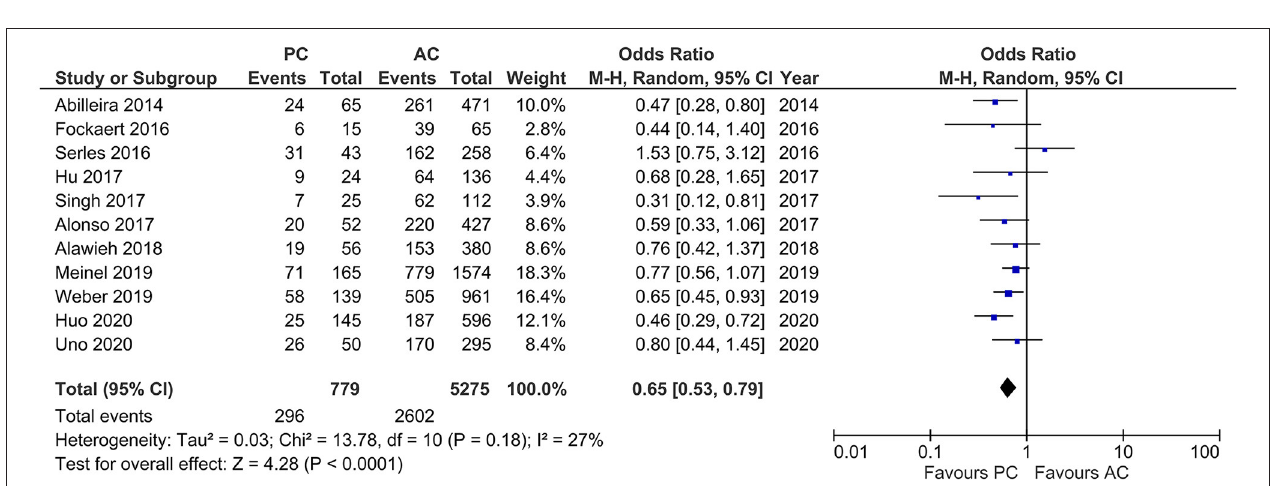
FIGURE 5 | Forest plot comparing rate of intravenous thrombolysis in patients with large vessel occlusion in the posterior circulation (PC) vs. anterior circulation (AC) who were treated with endovascular mechanical thrombectomy. Chi 2 , chi-square statistic; CI, confidence interval; df, degrees of freedom; I 2 , I -square heterogeneity statistic; M-H, Mantel–Haenszel statistic; P , p -value; Tau 2 , estimated variance of underlying effects across studies; Z , Z statistic.